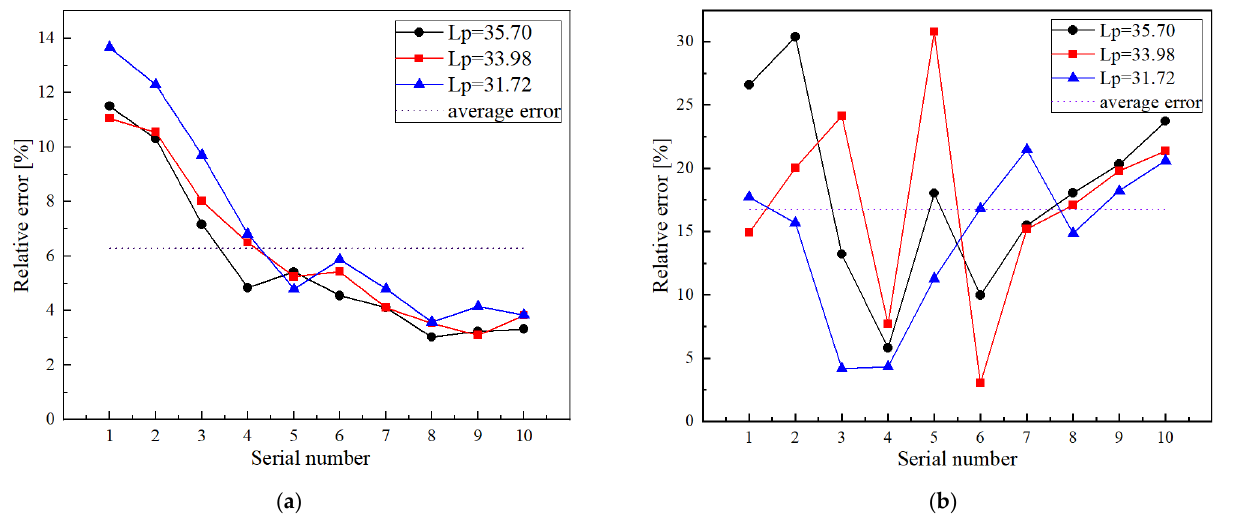
Figure 12. Relative error: ( a ) relative error of the proposed method; ( b ) relative error of the conven- tional acoustoelastic effect method.